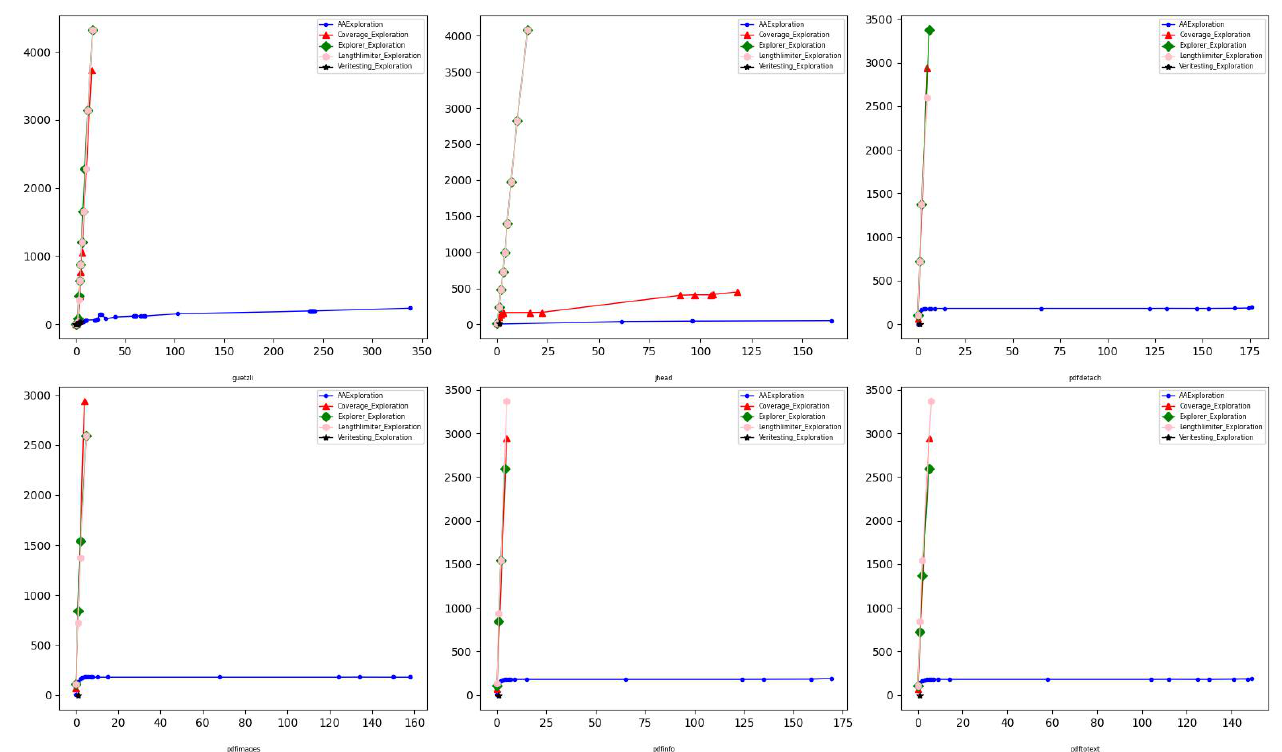
Figure 4. State space explosion mitigation capability when exploring programs that cause state space